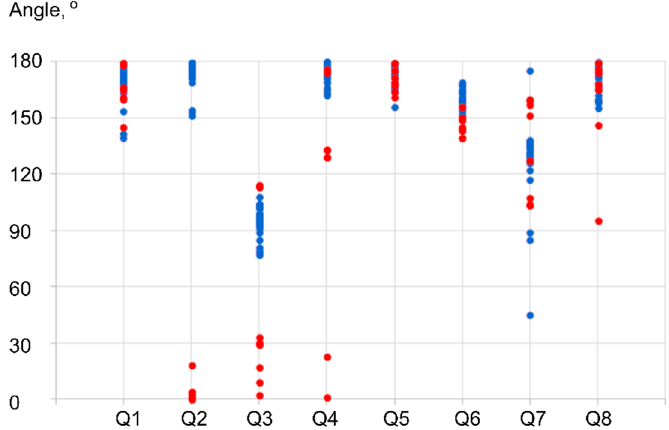
Figure 2. Modules of Q1–Q8 torsion angles of imatinib in (blue) extended and (red) folded Figure2. ModulesofQ1–Q8torsionanglesofimatinibin(blue)extendedand(red)foldedconformations conformations in 43 molecules found in 29 crystals. in 43 molecules found in 29